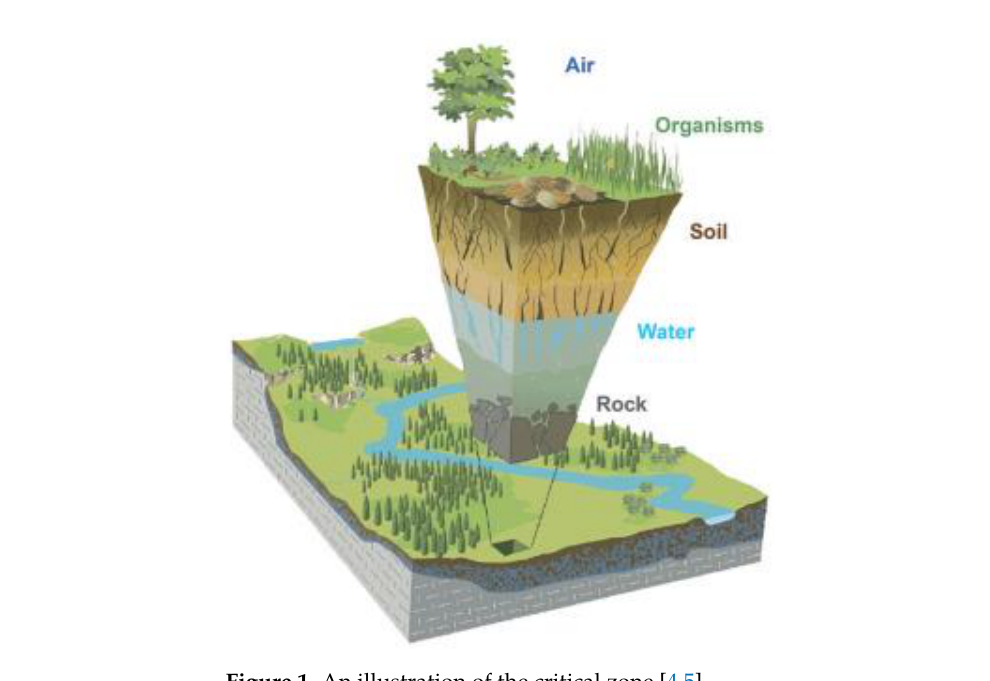
Figure 1. An illustration of the critical zone [4,5].